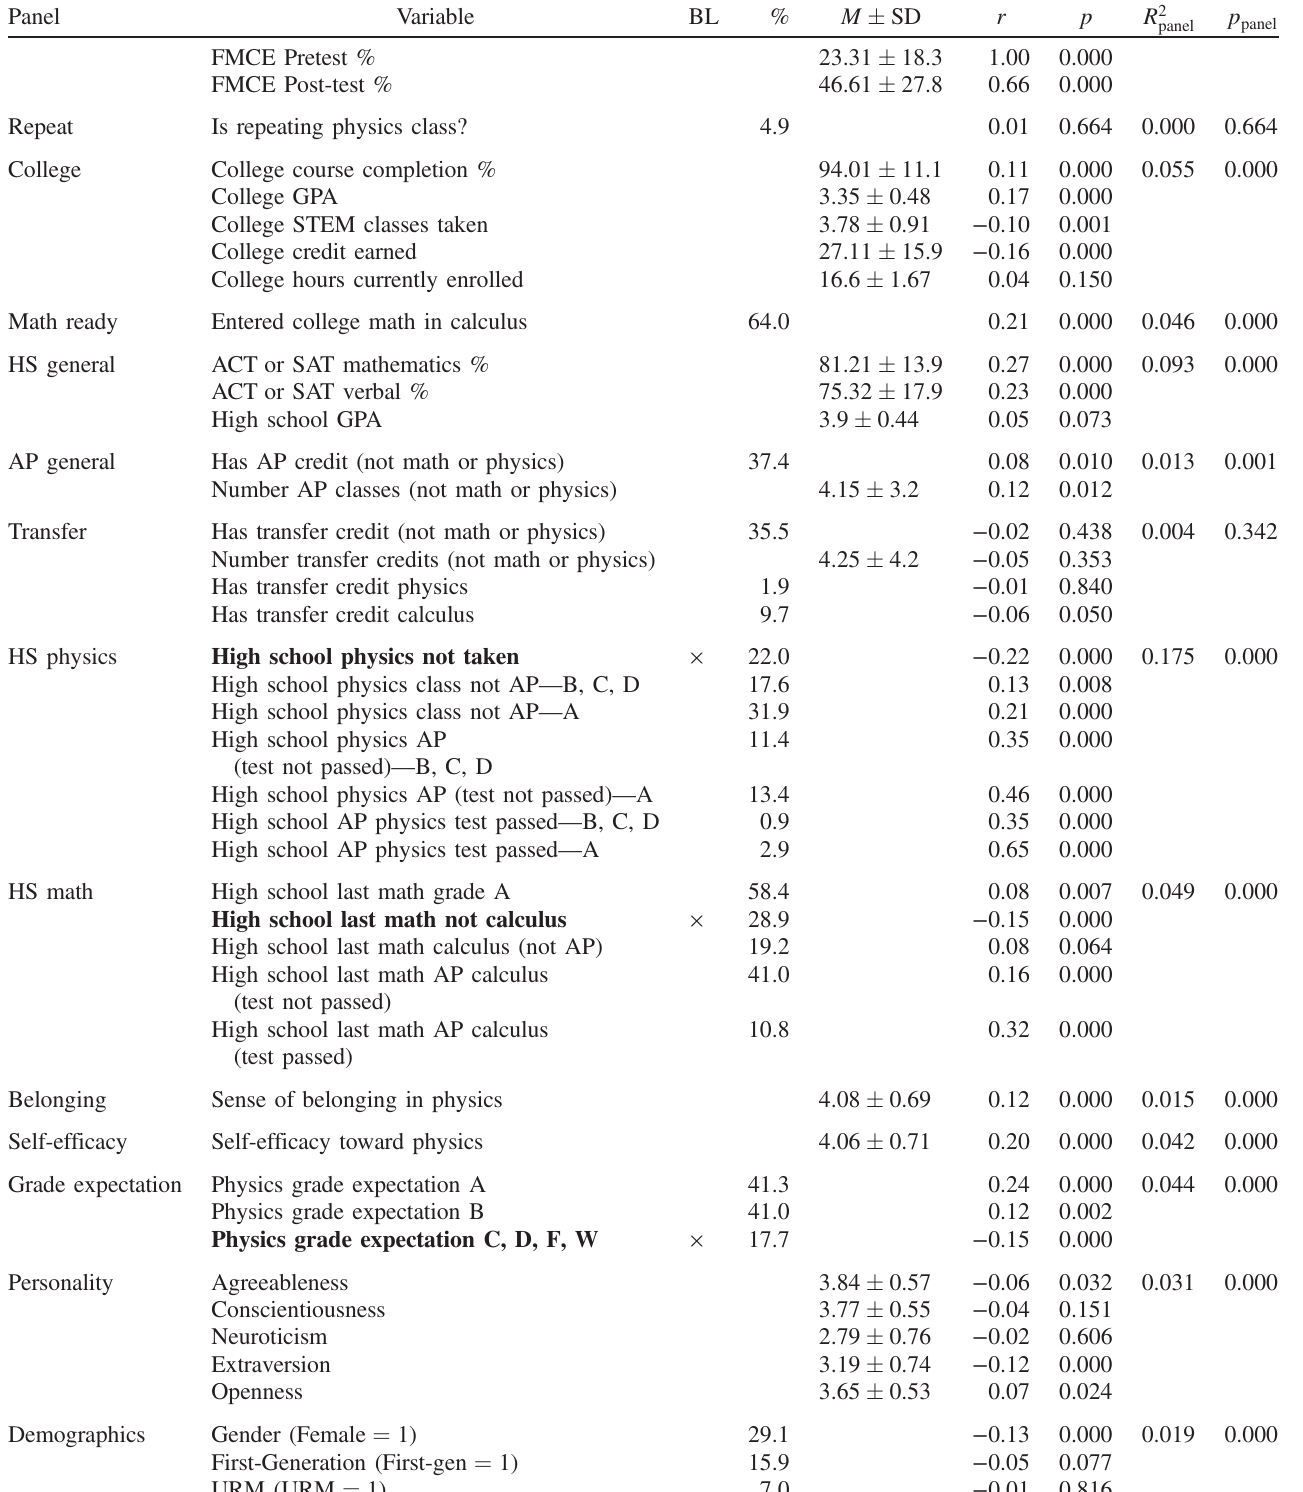
TABLE II. Descriptive statistics. The base level of a set of dummy-coded variables is given by BL and indicated in bold face. For dichotomous variables, the percentage of students in the high level of the variable is reported. For continuous variables, the mean ( M ) and standard deviation (SD) is presented. For all variables, the correlation r with pretest score and the probability that the correlation or a larger correlation occurred by chance p are